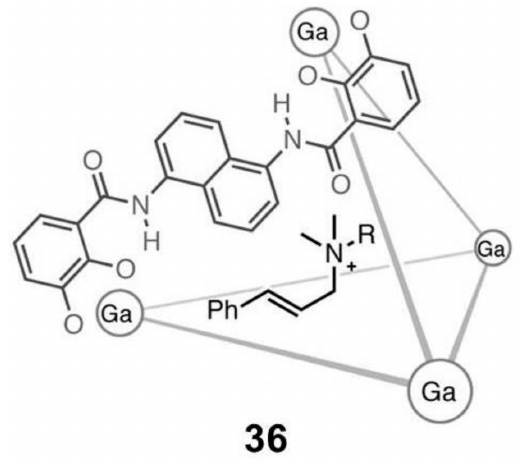
Figure 6. Ga-based tetrahedral capsule 36